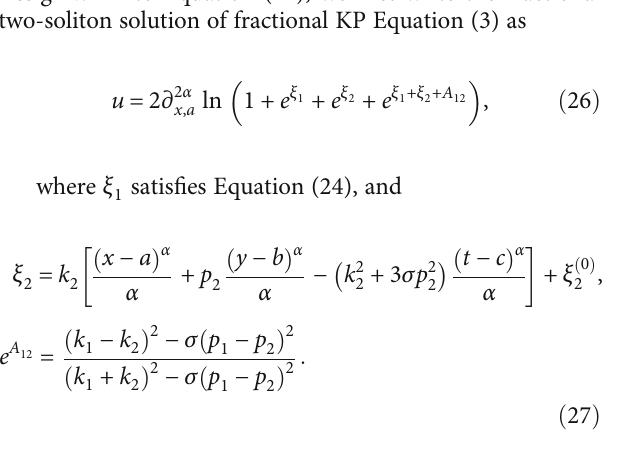
Figure 8 simulates a Y-type interaction without a stem. In addition,